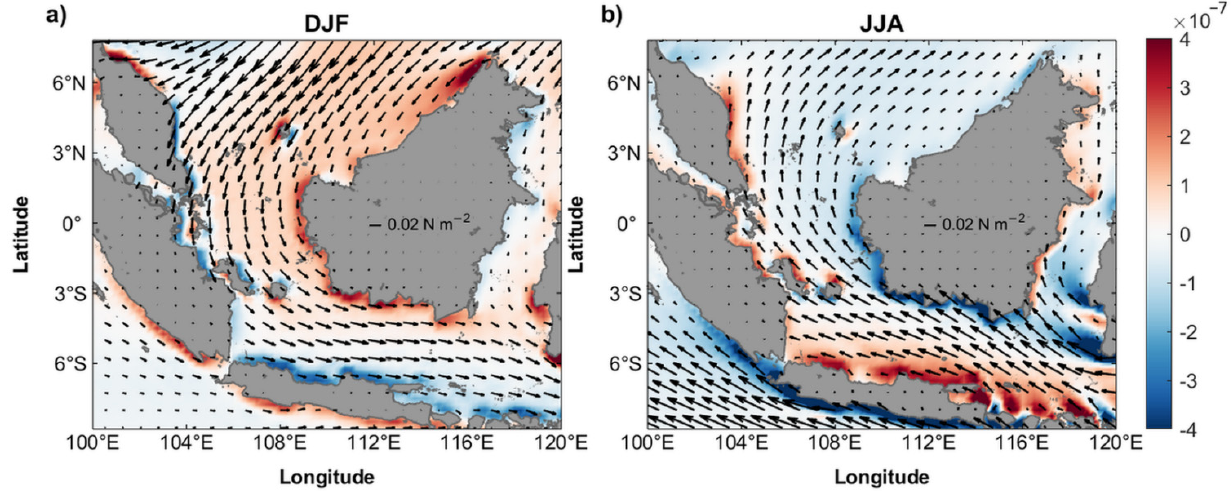
Figure 2. Seasonal wind stress vector (unit: N m − 2 ) and wind stress curl (unit: N m − 3 ; in shade) climatology during the ( a ) boreal winter and ( b ) boreal summer.